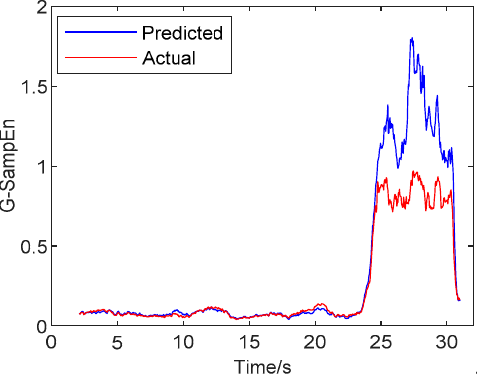
Figure 12. Dynamic G-SampEn of the first-order spatial mode amplitude.